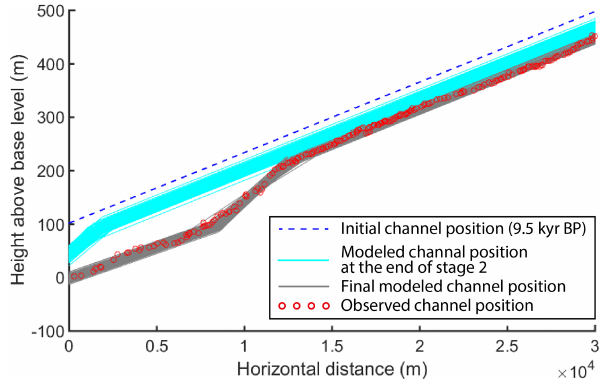
Figure 8. Monte Carlo simulation of channel position at the end of stage 2 and at present, end of stage 3, compared to the observed river profile. Results of 500 simulations are shown. Parameters for simulations were selected from valid model results for the timing, duration, and incision rate stages 2 and